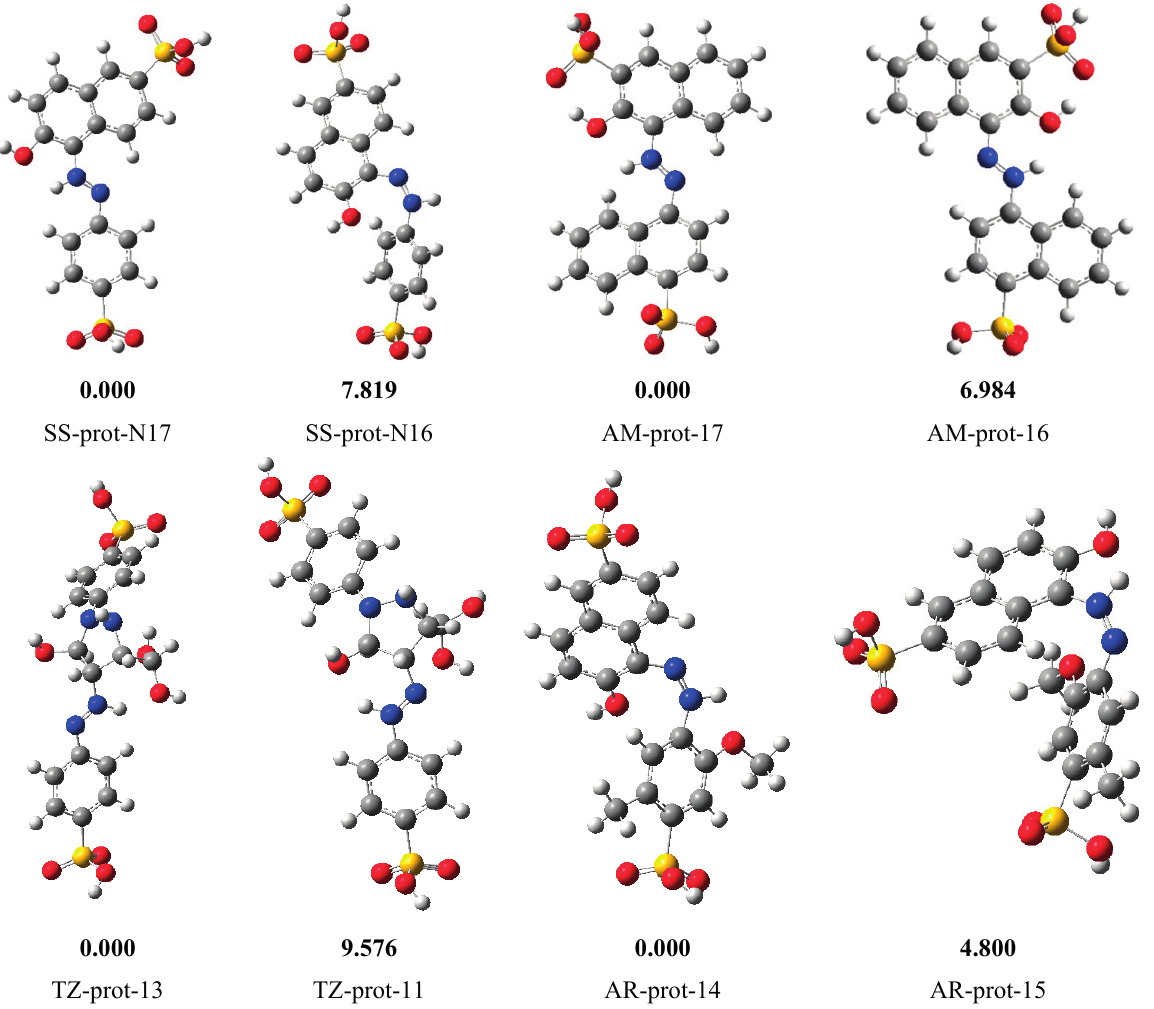
Figure 7. N-protonated species of the studied dyes. The number at the end of the name of the protonated species indicate the site on the molecule at which protonation is considered. Colour legend: White = Hydrogen; Grey = Carbon; Blue = Nitrogen; Red = Oxygen; Yellow =